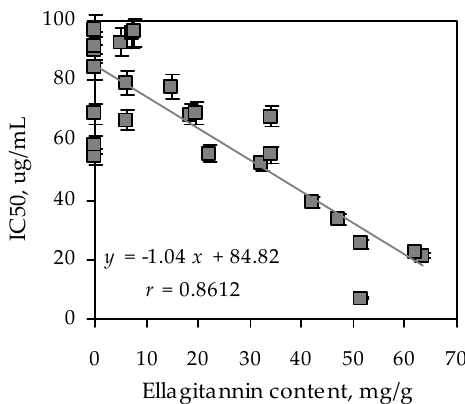
Figure 1. Correlation graph between ellagitannin content (mg / g; independent variable x in regression equation) in extracts of Rosaceous species and their α -glucosidase inhibiting activity (IC 50 , µ g / mL; dependent variable y in regression equation). r —correlation coefficient. Table 2. Known compounds found in Agrimonia species (literature data).